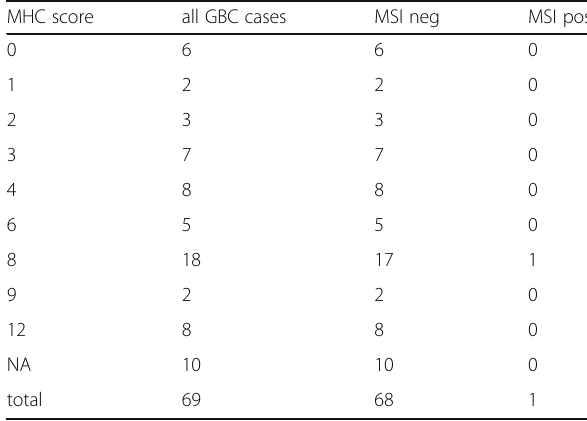
Table 2 MSI vs non-MSI gallbladder carcinomas with regard to MHC class I immunoreactivity